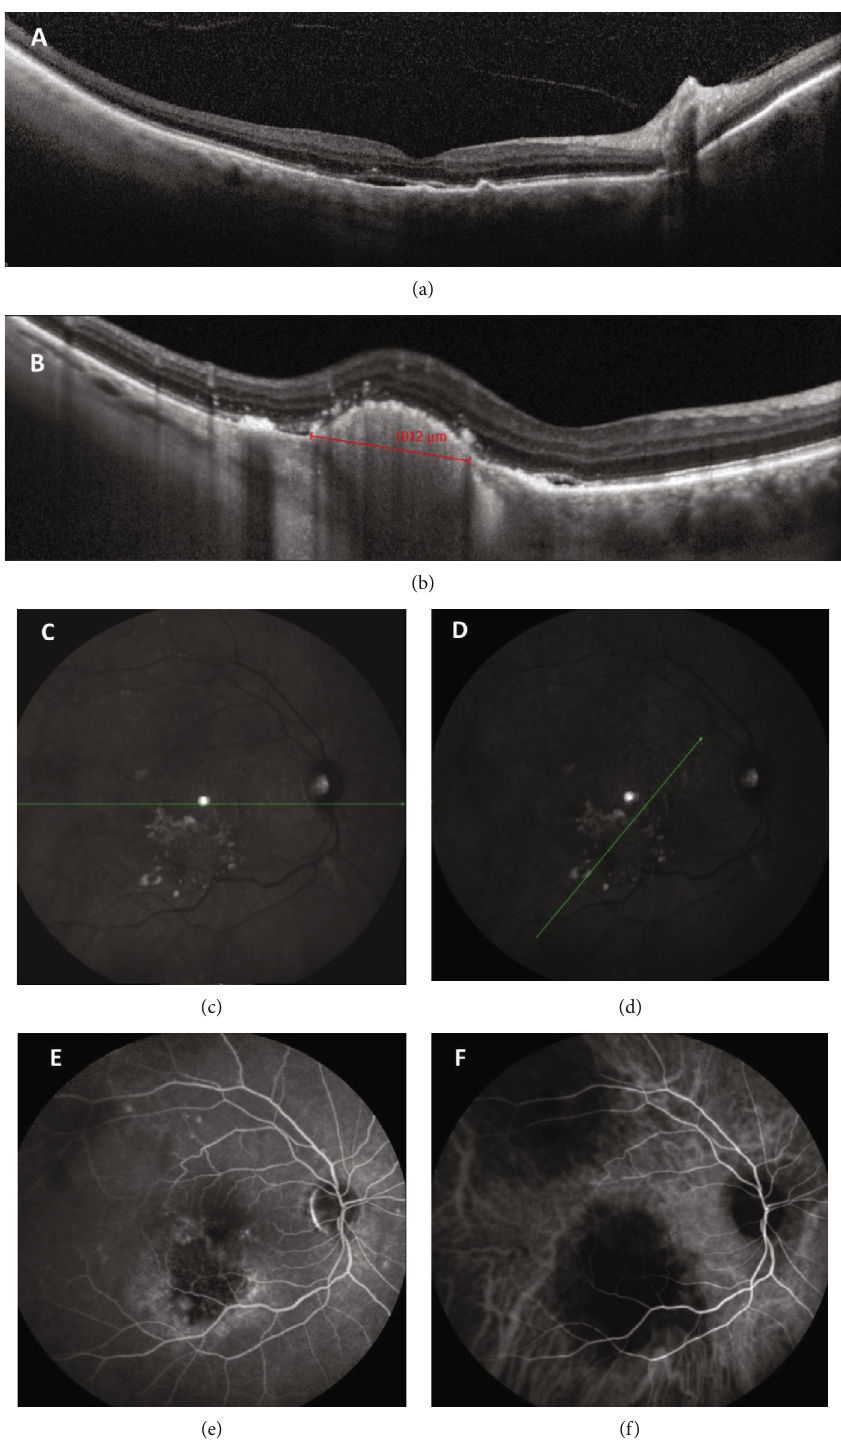
Figure 2: A metastatic lesion appears in the right eye fi ve months later. (a) Horizontal OCT showing a small neurosensory macular detachment, with discrete thickening of the RPE and of the outer foveal lines over the detachment. Scattered hyperre fl ective foci within the retina. Note the loss of typical choroidal texture under the serous detachment. (b) OCT showing a choroidal mass with moderate internal re fl ectivity on OCT superior to the inferior temporal arcade, measuring 1,912 μ m in diameter, with no overlying choriocapillaris. Overlying hyperre fl ective foci and contiguous neurosensory foveal detachment are seen. (c, d) IR image depicts numerous whitish subretinal clumps suggesting fi brin along both vascular arcades. The green lines represent the axial orientation of the B-scans of images (a) and (b), respectively. (e) FA shows a hypo fl uorescent plaque surrounded by mottled hyper fl uorescence in the inferior temporal arcade. (f) Hypo fl uorescent plaques on ICG along the superior and inferior vascular